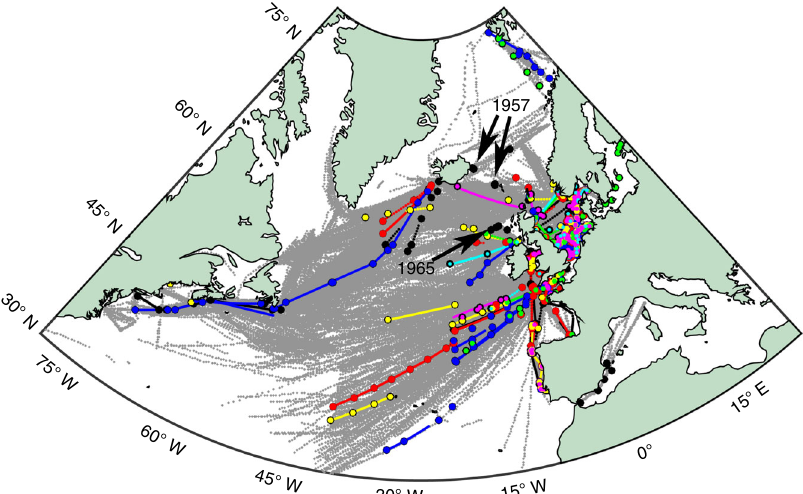
Fig. 2 Map of macroplastics in the North Atlantic and adjacent seas. Map showing the location of Continuous Plankton Recorder samples since 1957 shown as grey points, black circles = macroplastic occurrence that has not been categorized, red circles = netting, blue circles = line, yellow circles = rope, green circles = bag, pink circles = mono fi lament, and cyan circles = string. The location of the two earliest records of macroplastic are annotated with the year they were recorded and black arrows. Note: The white area are where no data are